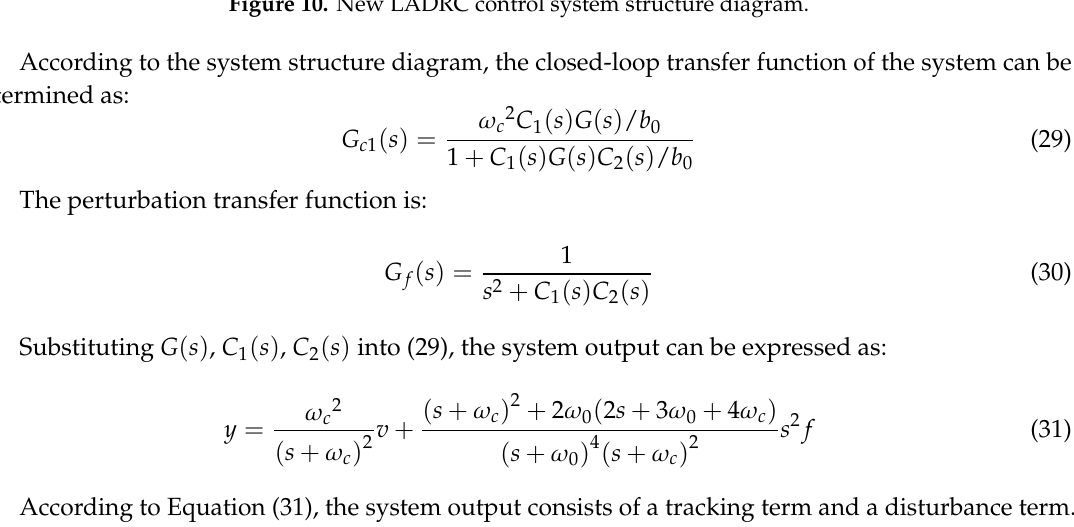
Figure 10. New LADRC control system structure diagram.